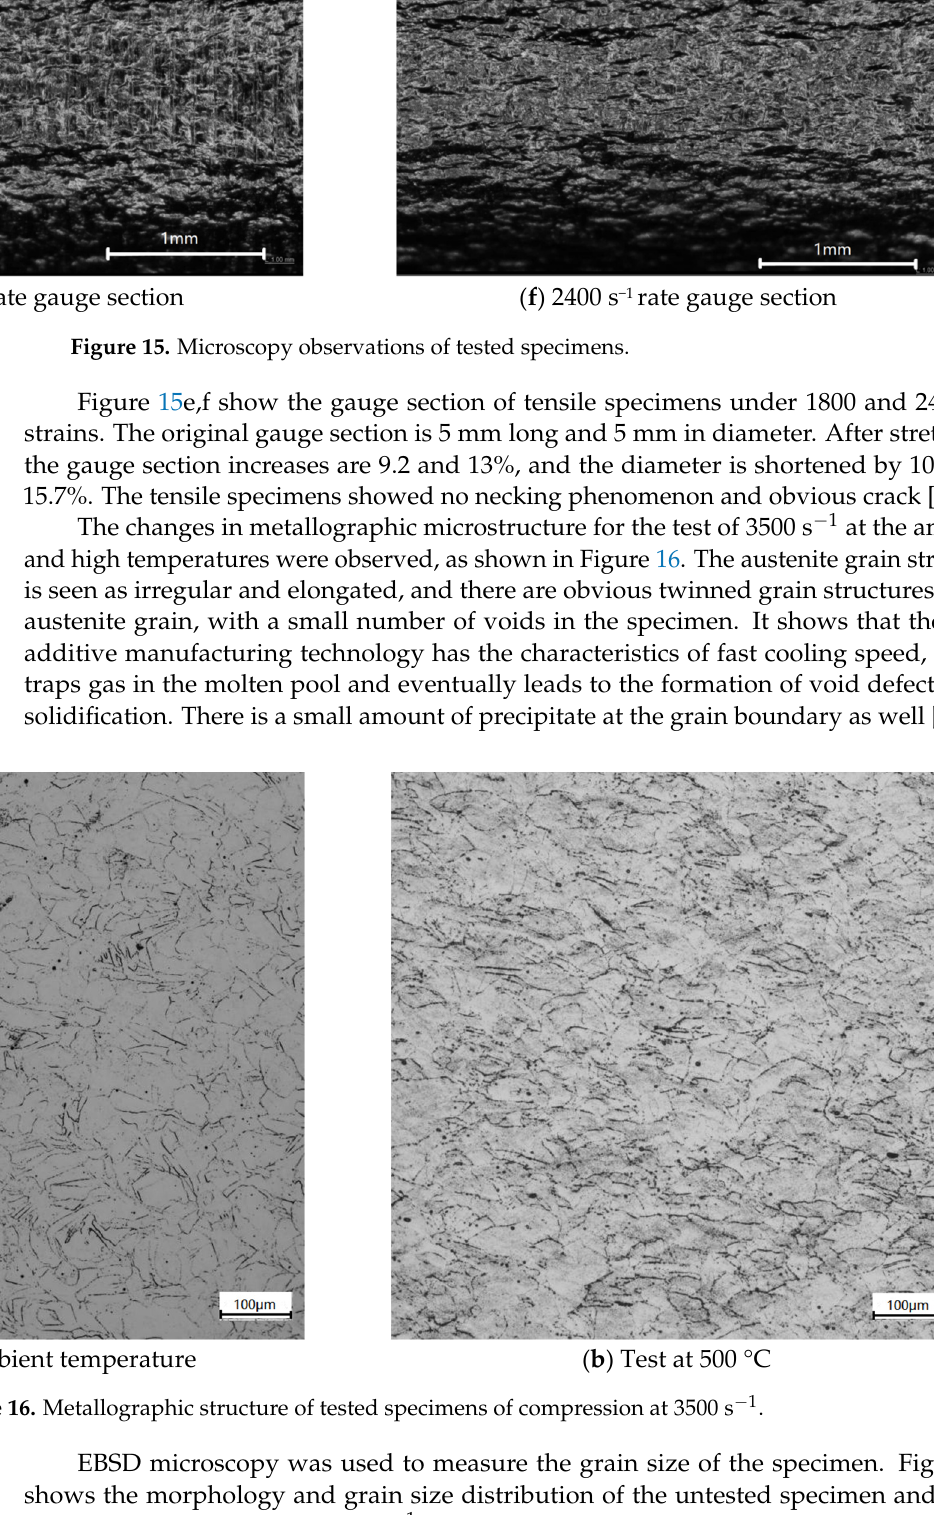
Figure 16. Metallographic structure of tested specimens of compression at 3500 s − 1. EBSD microscopy was used to measure the grain size of the specimen. Figure 17 shows the morphology and grain size distribution of the untested specimen and those compressed dynamically at 3500 s − 1 under the ambient and high temperature, respectively. The average grain sizes are approximately 17.53, 14.91, and 10.84 μ m, respectively, showing an average grain size reduction of 15 and 28.2%, respectively, in the two tested specimens. Because the laser-melted Inconel 625 alloy belongs to the lower- level fault-energy material, and dislocation is easy to decompose into lamination, the width of extended dislocation is large, difficult to bundle and slip, and prone to twinning deformation. The grain refinement of the alloy is mainly affected by the dislocation